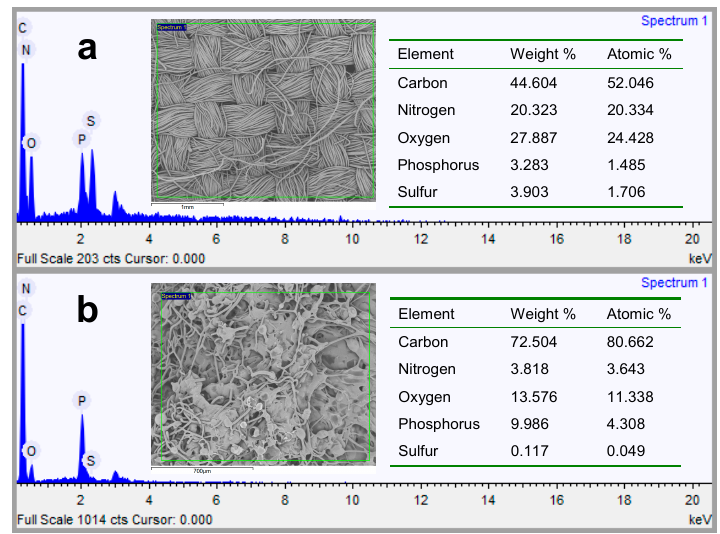
Figure 11. P content of wool fibers and corresponding char residues determined using ICP-OES.